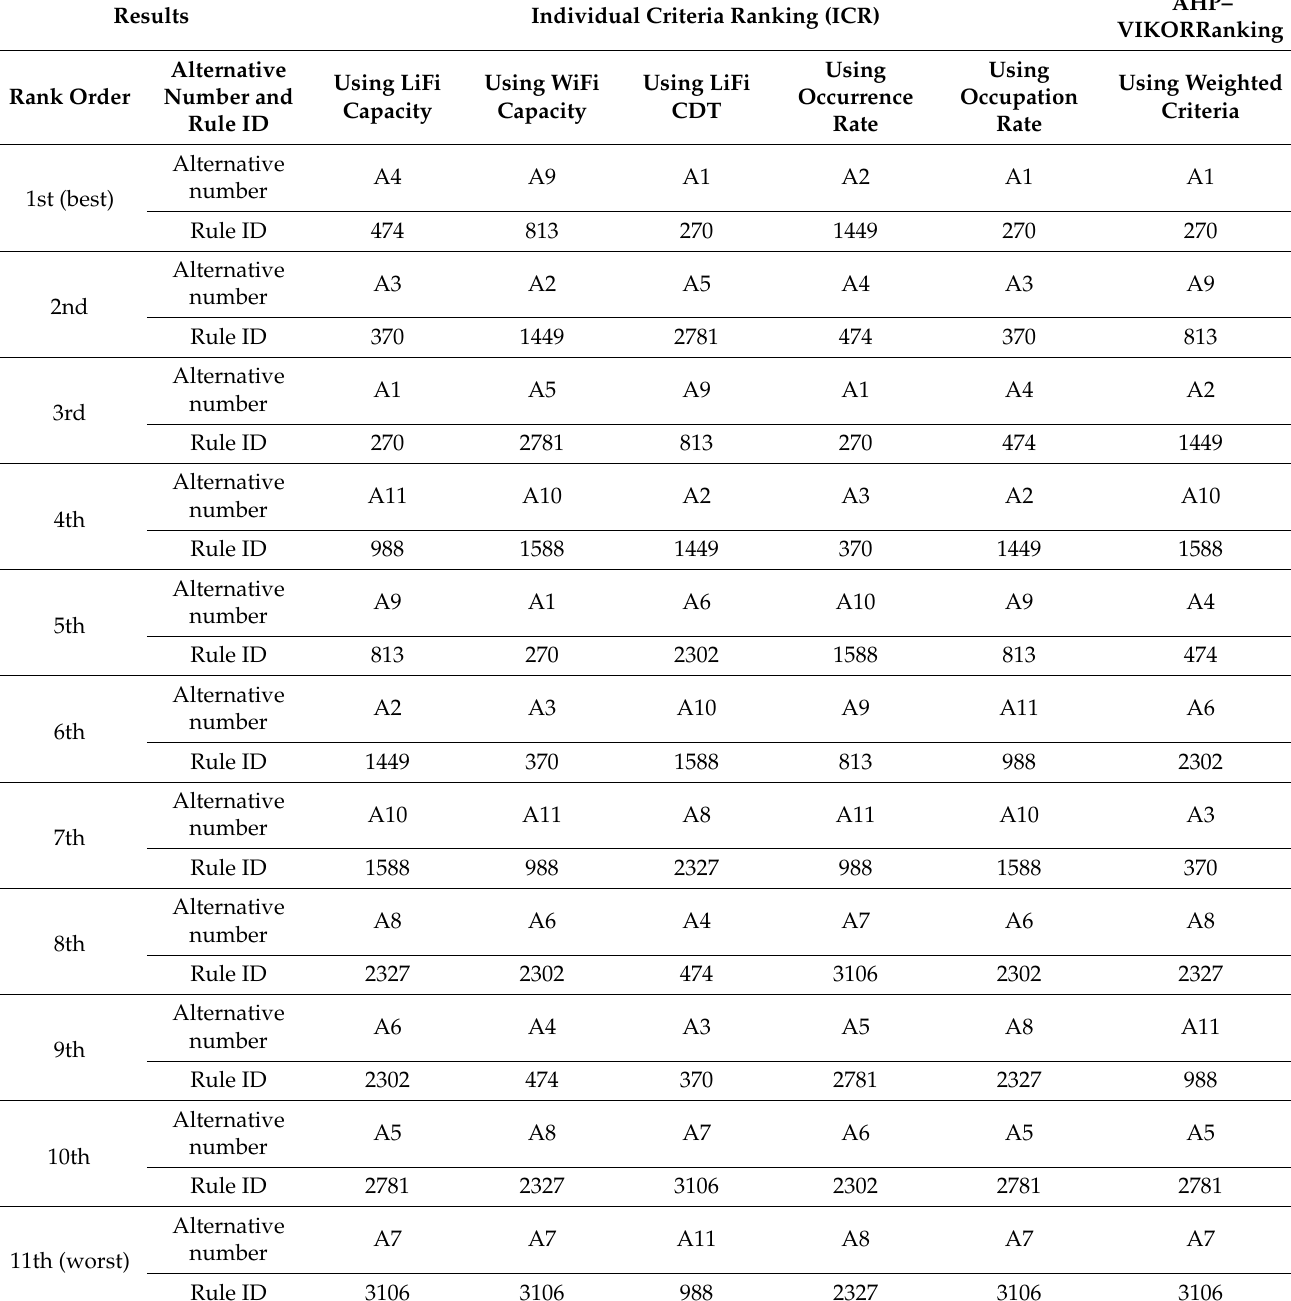
Table 23. Comparisons of criteria ranking before and after using